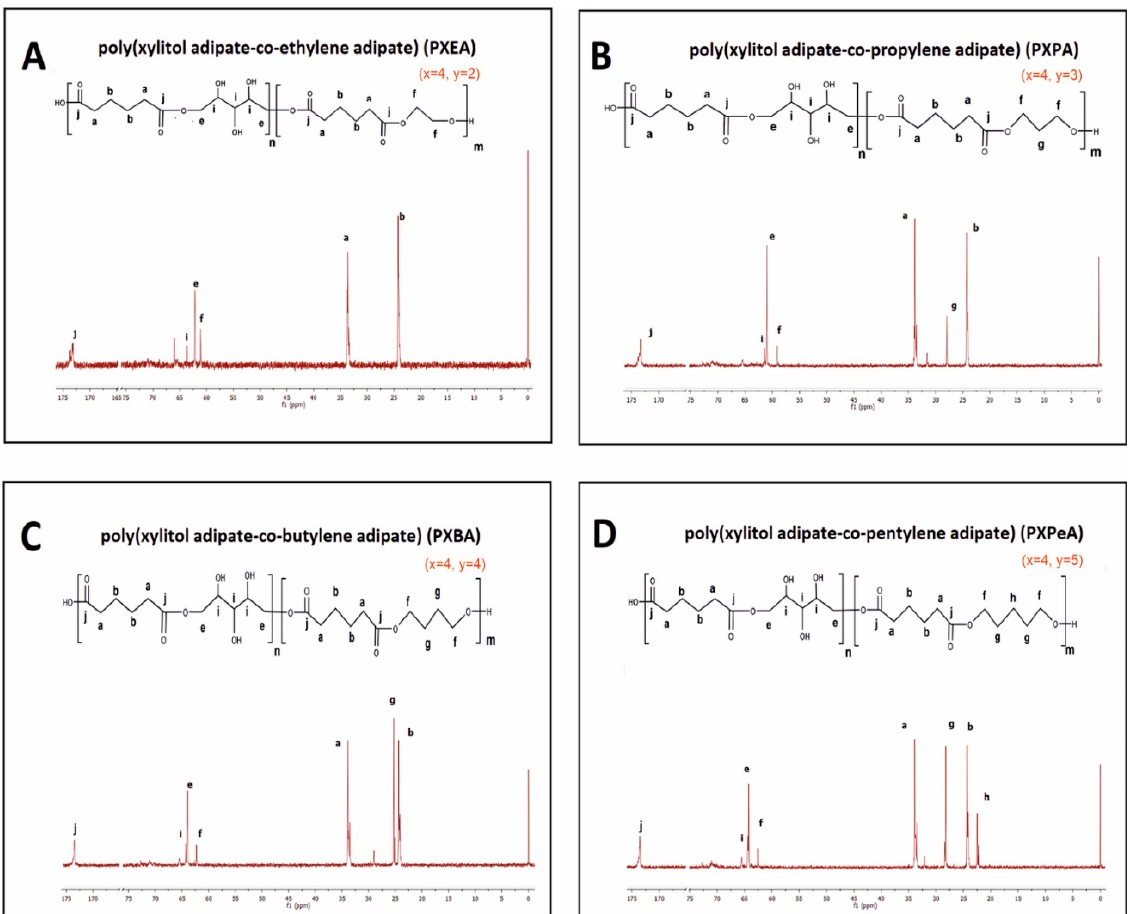
Figure 5. 13 C NMR of PXEA ( A ), PXPA ( B ), PXBA ( C ), and PXPeA ( D ) prepolymers.